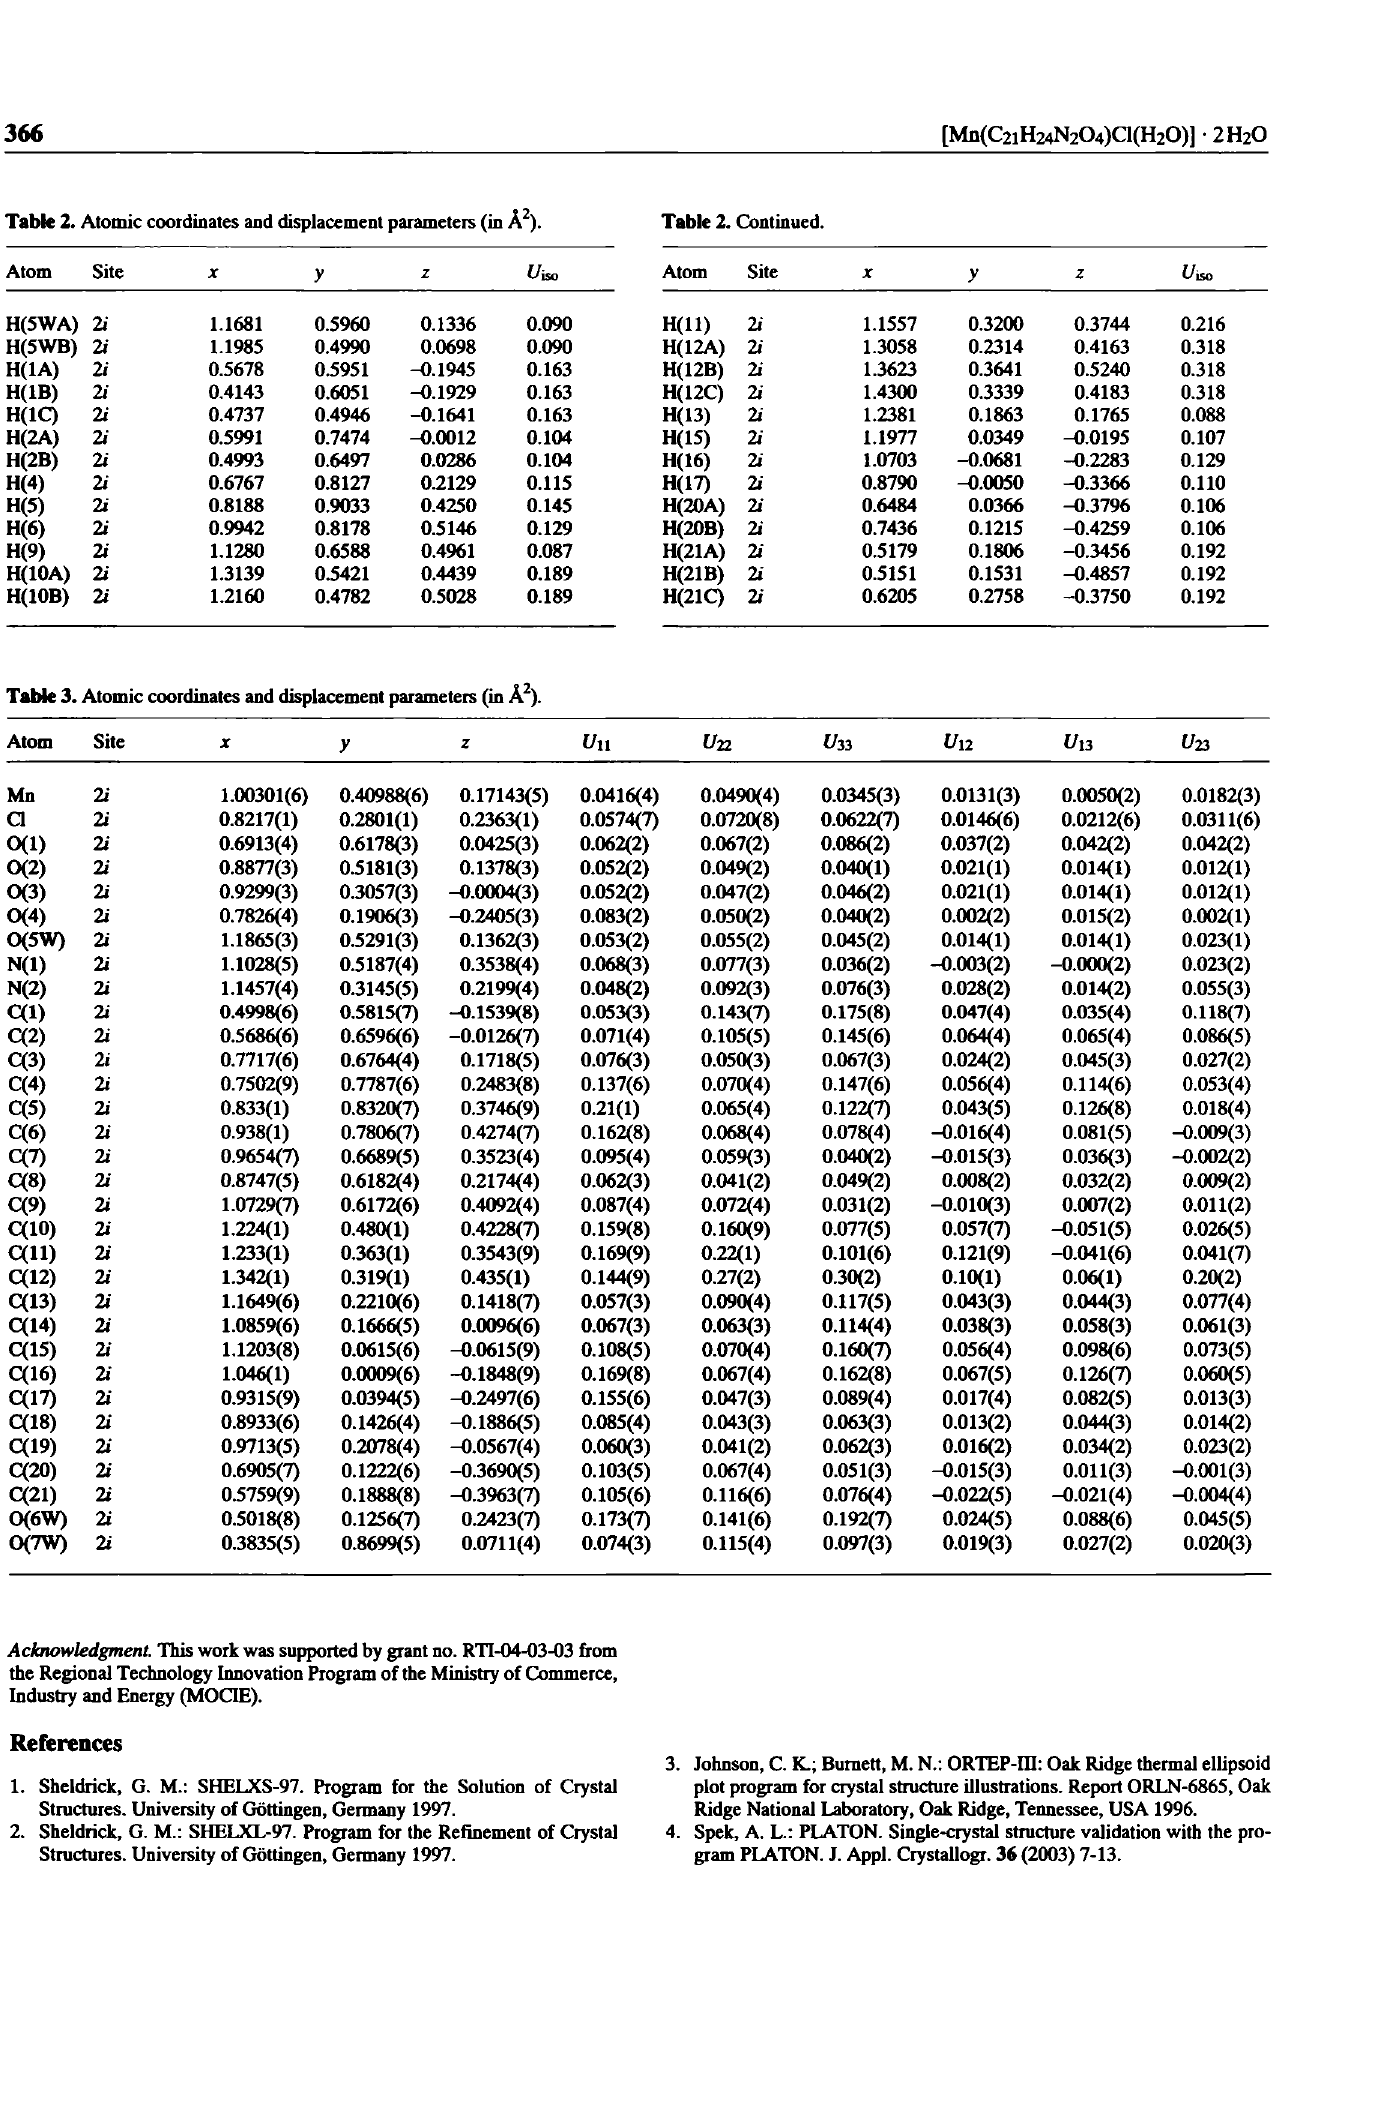
Table 3. Atomic coordinates and displacement parameters (in Ä 2